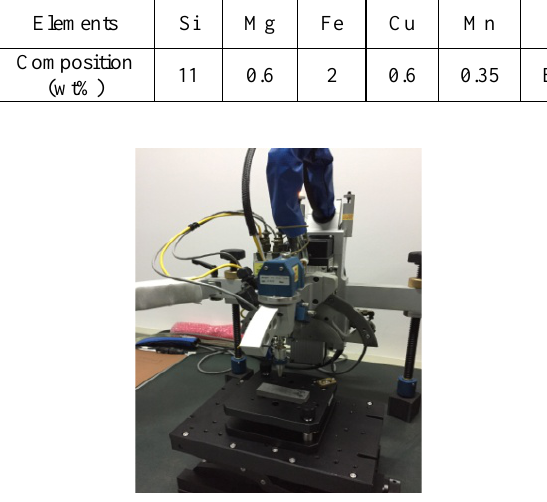
Table 2. Chemical composition of AlSi10Mg